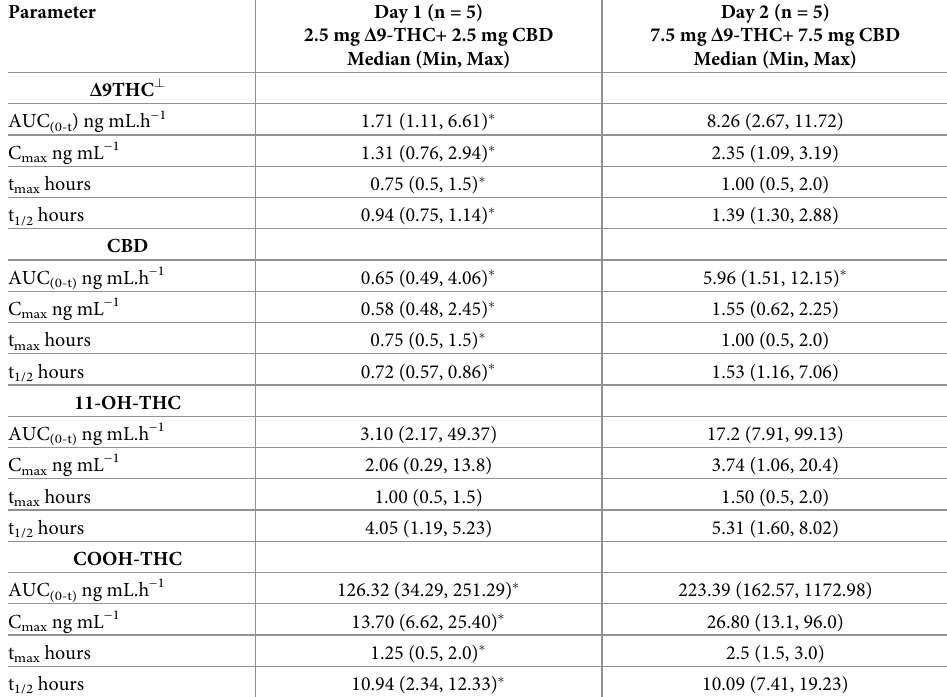
Table 4. Summary of Stage I two dose-approach of n = 5 (100%) (one dose escalating to three doses) cannabinoid pharmacokinetic parameters.